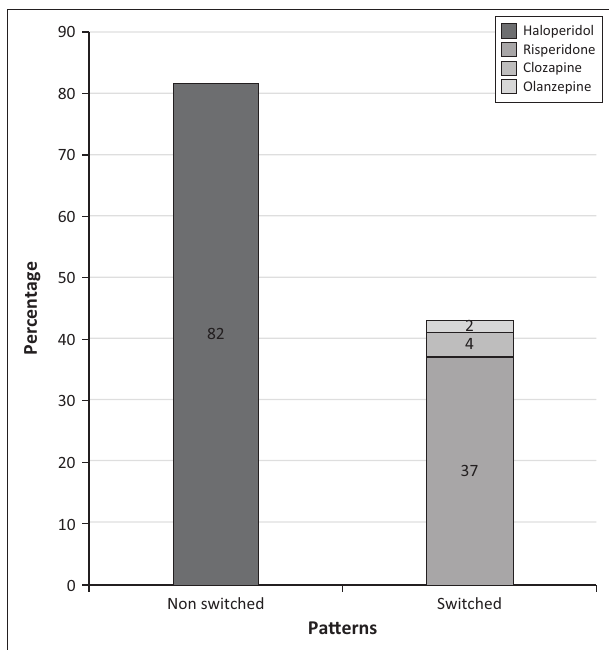
FIGURE 3: Patterns of antipsychotic